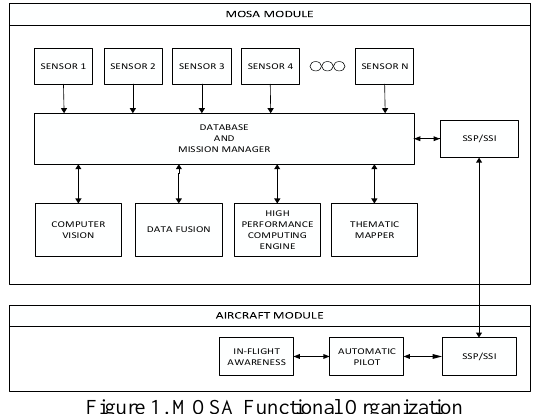
Figure 1. MOSA Functional